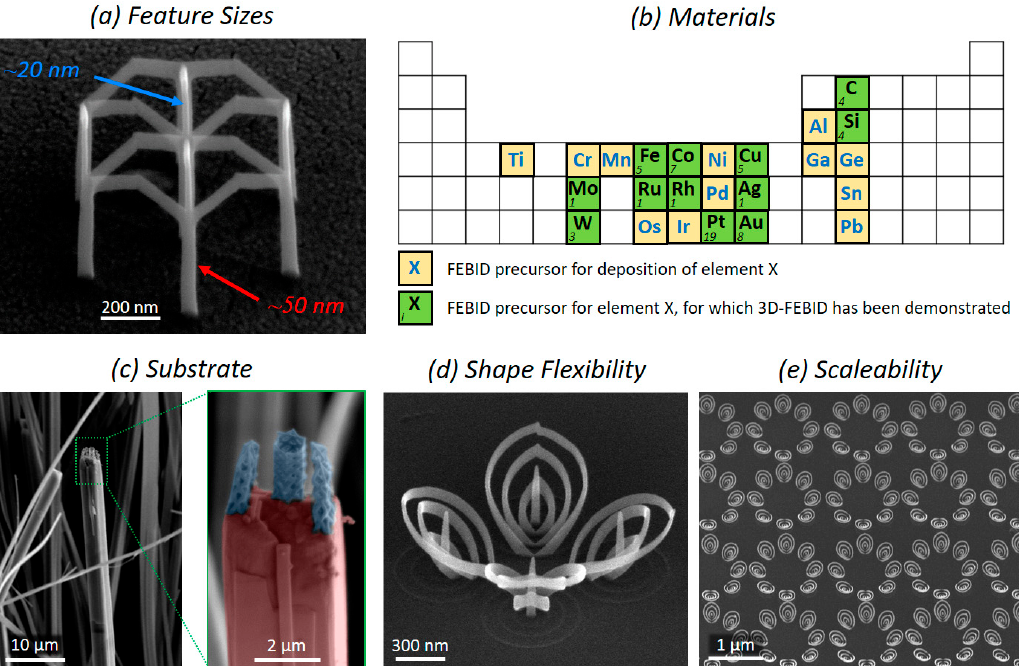
Figure 1. Aspects of 3D nano-printing via focused electron beam-induced deposition (FEBID): ( a ) Feature sizes of a Pt–C multi-pod structure in 52° tilted view. The diameter of individual nanowires is routinely well below 100 nm, while 20 nm can be achieved for special FEBID conditions; ( b ) Materials: a large number of precursors allow the deposition of materials containing different chemical elements [43]. While for some, the fabrication of freestanding 3D objects has been demonstrated (green) in various studies (numbers in the left corners correspond to the number of articles for the respective element) [34], the suitability for 3D-FEBID of other (2D)-FEBID precursors (yellow) is still pending; ( c ) Pt–C based FEBID 3D nano-towers fabricated on top of mineral wires, which is extremely challenging via alternative techniques. Adapted and reprinted from Winkler et al., ACS Appl. Mater. Interfaces 2017 [44]; ( d ) In addition to straight segments, arbitrarily curved nano-wires are possible; ( e ) Fabrication of multiple 3D geometries with 640 elements over several µm² in a single process step.